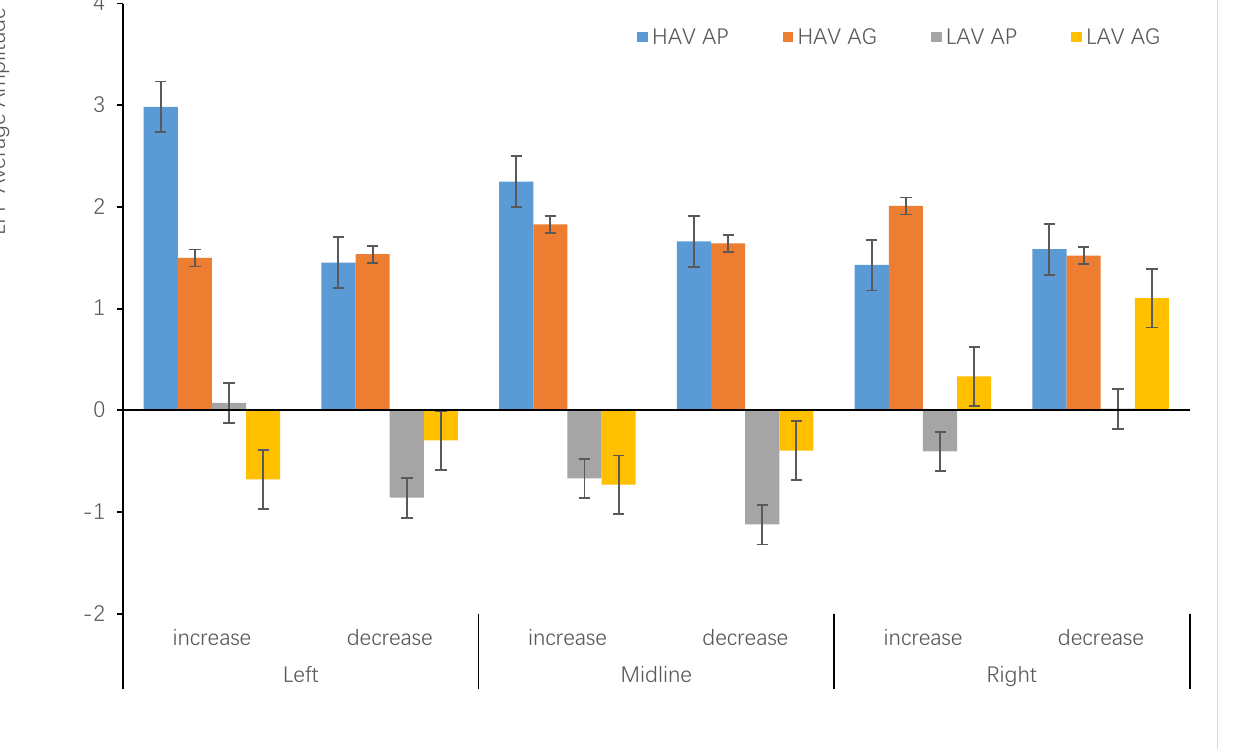
Figure 8. The descriptive statistics bar graph of the average amplitude of LPP regarding the hemi- sphere and emotion regulation.